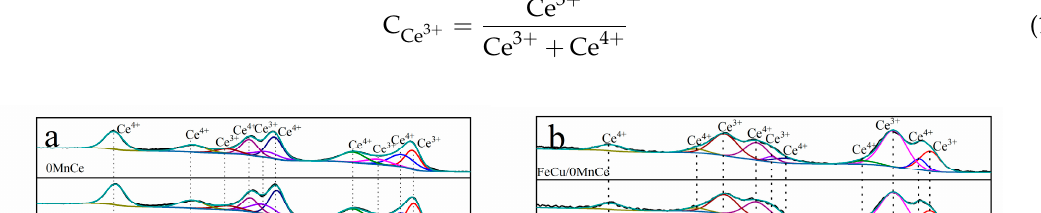
Figure 2. CO-TPD profiles: ( a ) supports, ( b ) fresh catalysts.